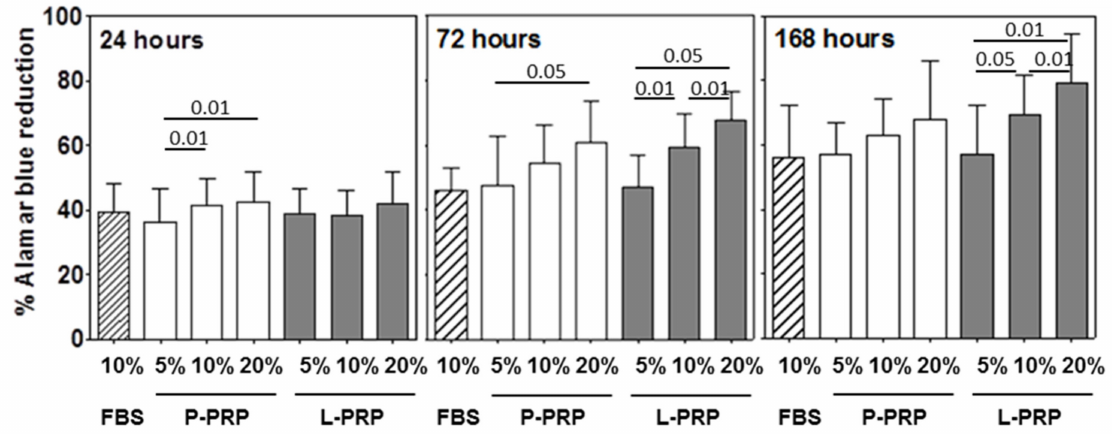
Figure 5. Synovial fibroblast growth following incubation with P-PRP and L-PRP. Results are reported as means and standard deviations; p value significances are reported, as determined by Wilcoxon matched pairs test. Differences among incubation times and PRP concentrations are reported below, as determined by Friedman Anova test. Comparisons among incubation times (24 h, 72 h, 168 h) for each concentration: FBS 10%, p < 0.02; P-PRP: 5% and 10%, p < 0.005; 20%, p < 0.002; L-PRP: 5%, p < 0.05; 10%, p < 0.005; 20%, p < 0.002. Comparisons among PRP concentrations (5%, 10%, 20%) for each incubation time: P-PRP: 24 h, 72 h, and 168 h, p < 0.005; L-PRP: 24 h, not significant; 72 h, p < 0.0005; 168 h, p <